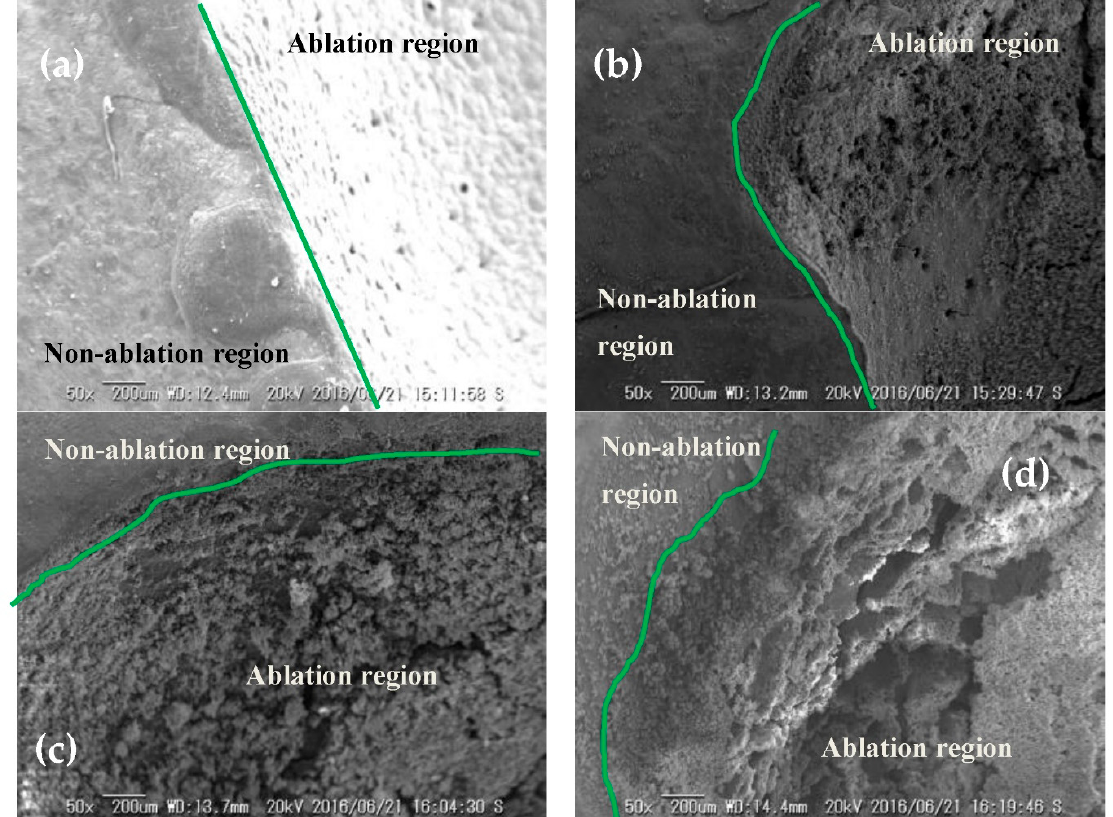
Figure 6. Surface morphology characteristics of specimens after arc ablation: ( a ) PTFE, ( b ) PTFE-BN-3, ( c ) PTFE-BN-7, and ( d ) PTFE-BN-11.